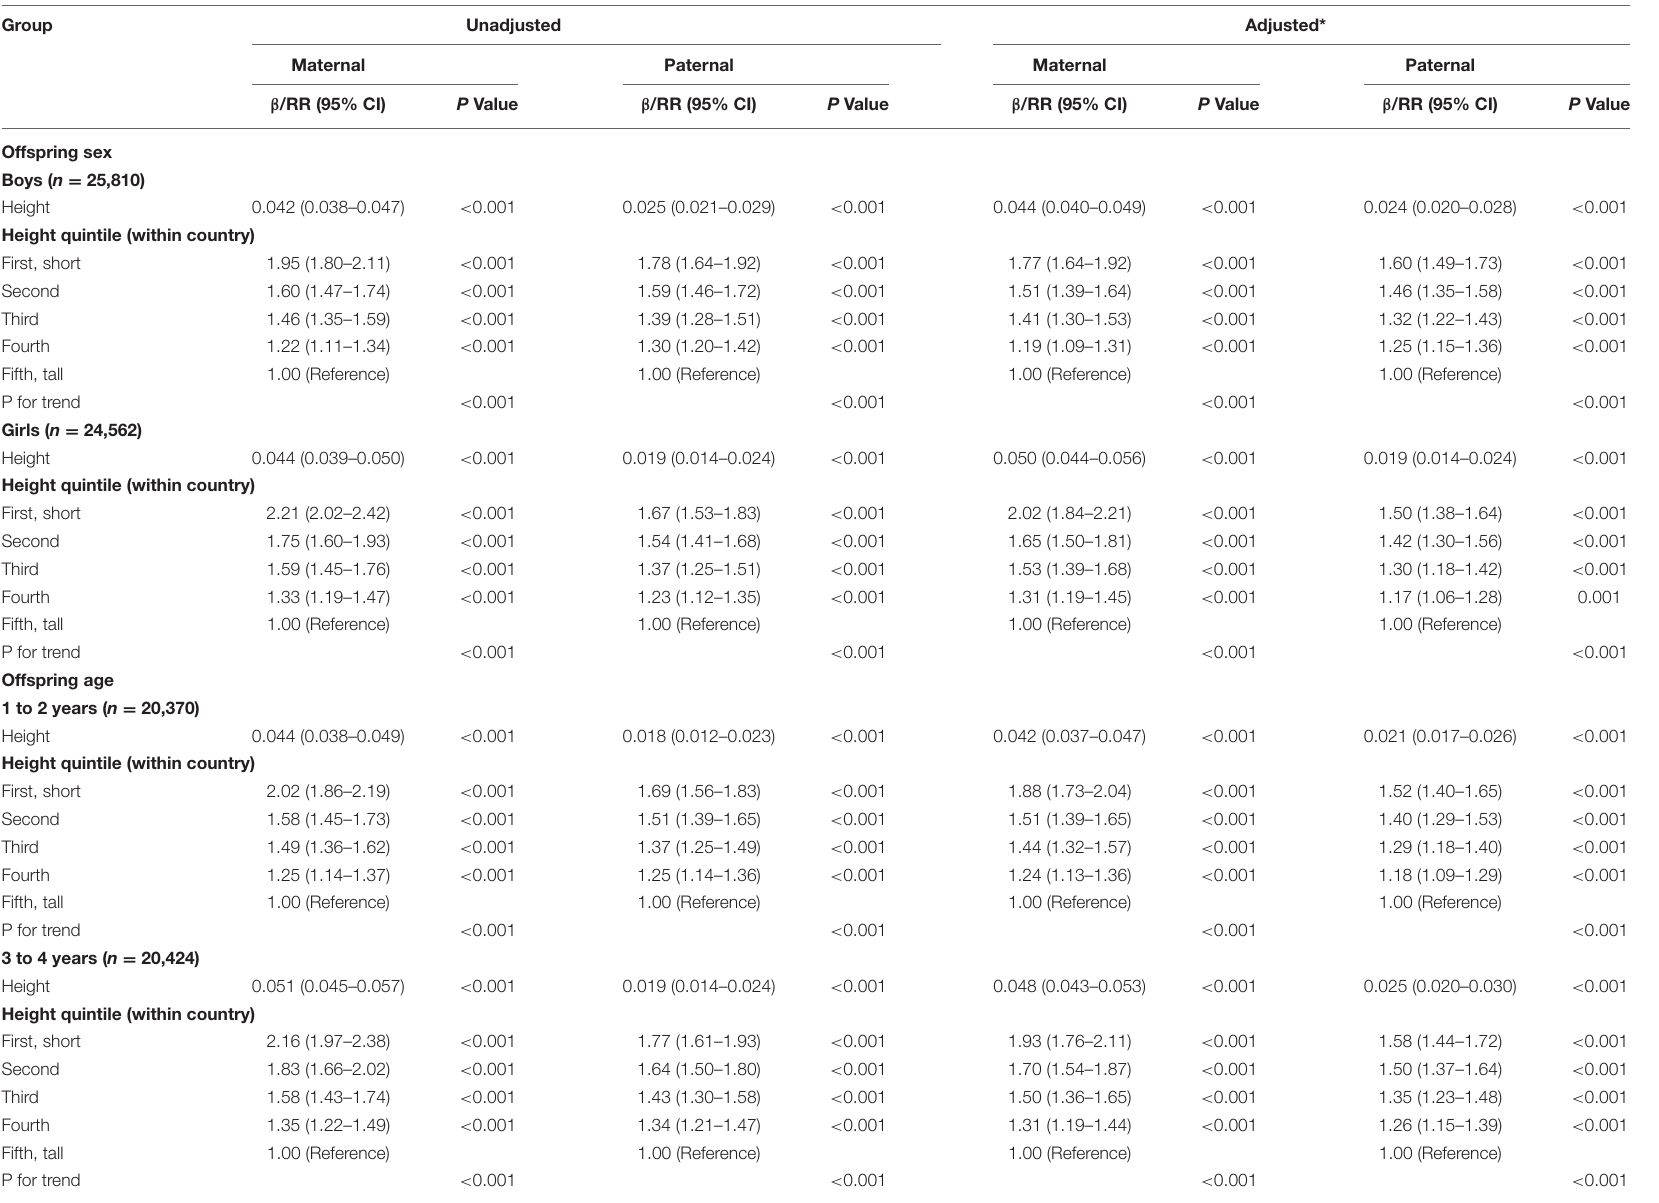
TABLE 3 | Unadjusted and adjusted β between maternal and paternal height and child HAZ and RR between maternal and paternal height quintile and children stunting with their 95% CIs by child sex and age.